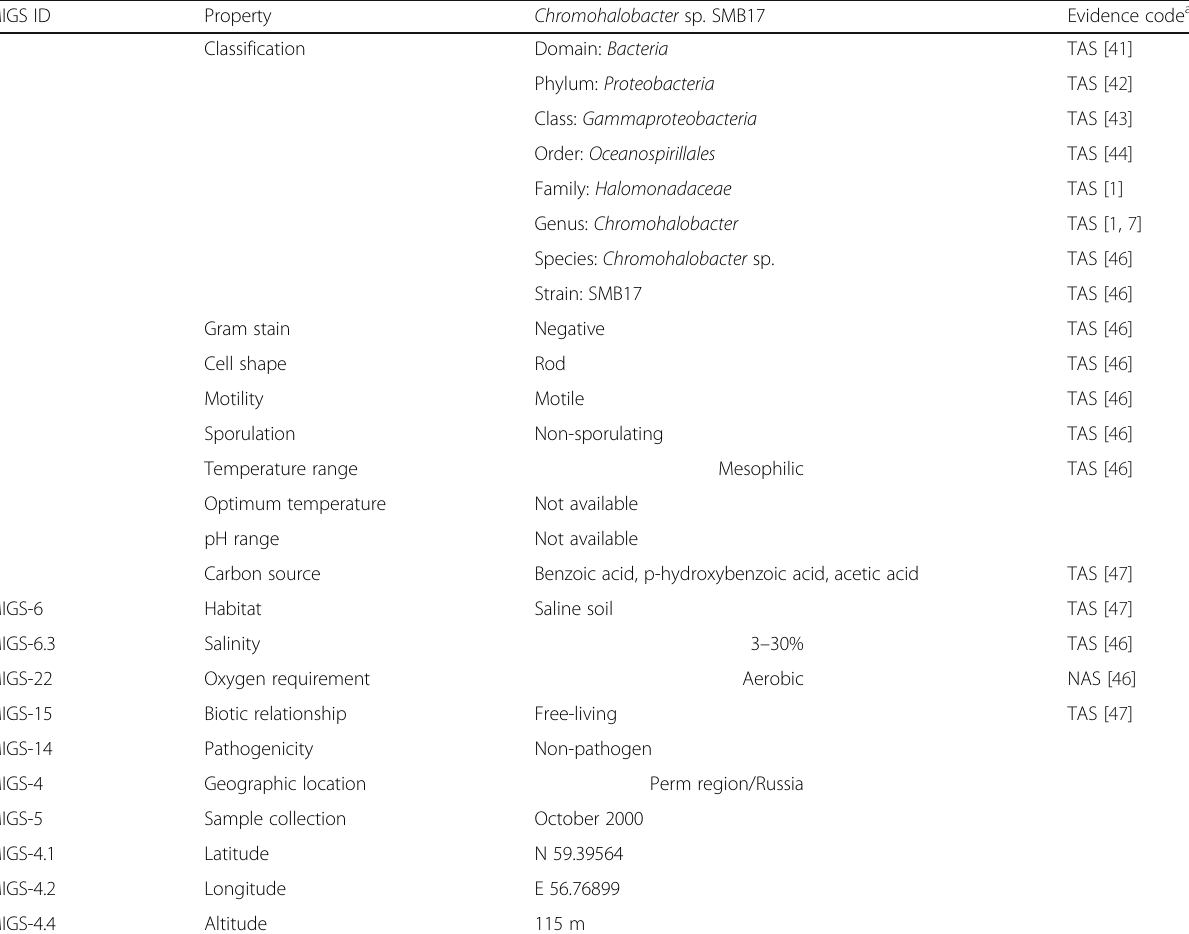
Table 3 Classification and general features of Chromohalobacter sp. SMB17 MIGS